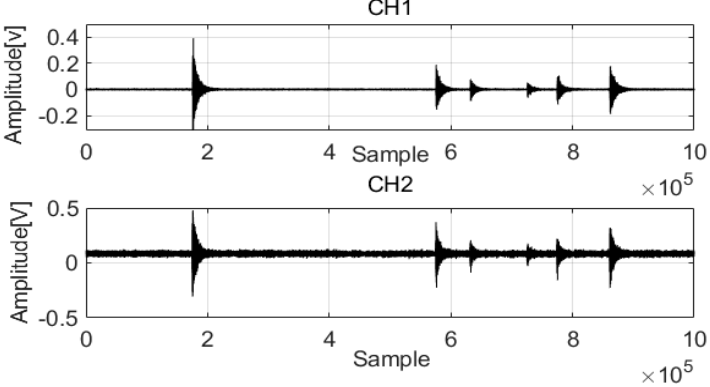
Figure 8. Acoustic waves of two channels.